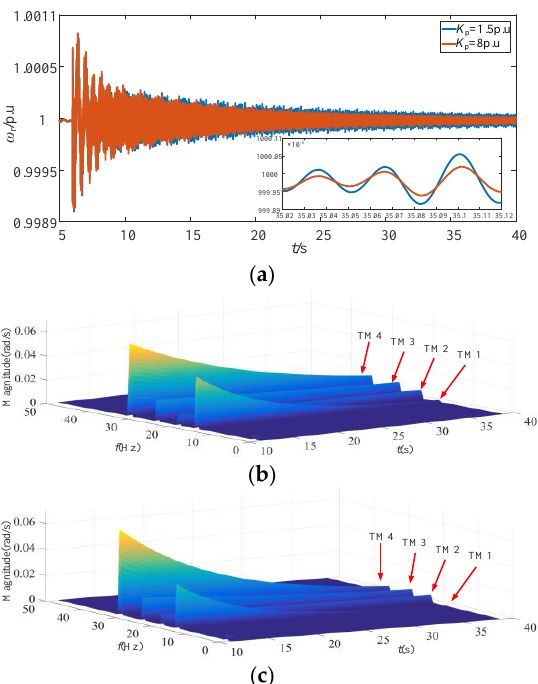
Figure 11. Rotor speed response of SG and the time–frequency analysis result: ( a ) rotor speed response curve; ( b ) K p = 1.5 p.u; ( c ) K p = 8 p.u.